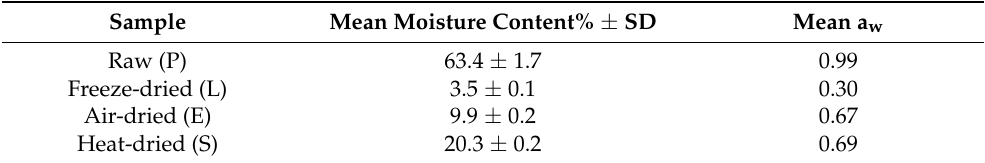
Table 1. Mean ( ± SD) moisture content (%) and mean a w for each tomato by-product, both raw and treated, as described in Section 2.3. By-product: raw (P), freeze-dried (L), non-thermal air-dried (E), and heat-dried